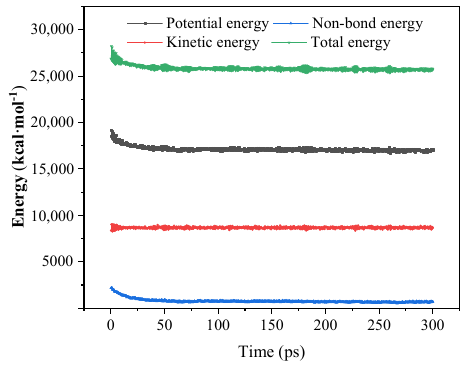
Figure 11. Energy changing during simulation.